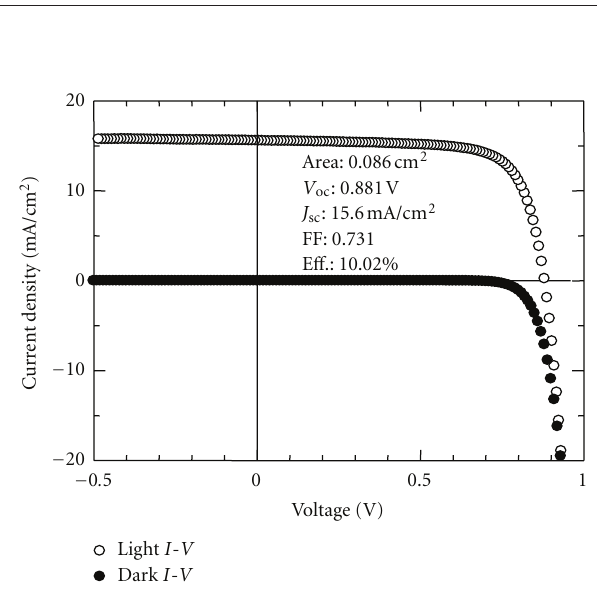
Figure 5: Photo- and dark I - V characteristics of the p-i-n solar